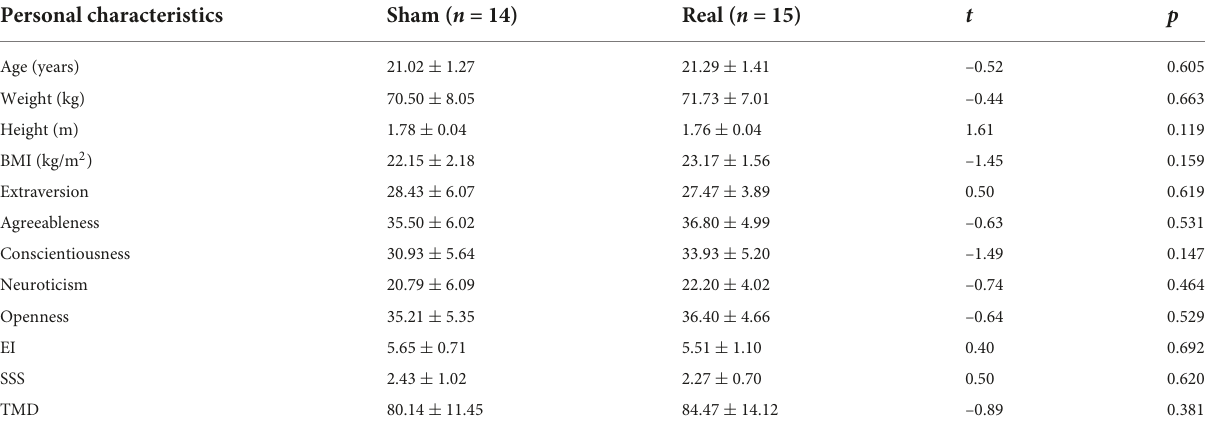
TABLE 1 Participant demographic and personality characteristics (Mean ± SD